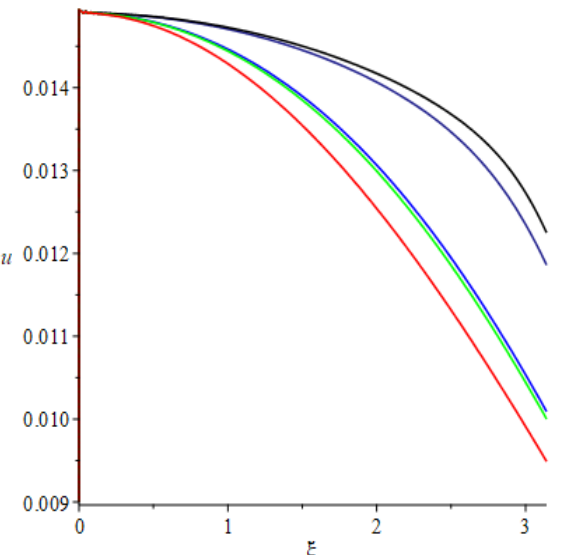
Figure 9. Graphs of the dependence of the phase velocity u on the wave number | ξ | in dimensionless variables. Red color: monodisperse phonon crystal 0.5 + 0.5. Black color: Medium drop + Medium bubble + Medium drop + small bubble with dimensions 0.25 + 0.3 + 0.25 + 0.2, a graph of phase velocities. Green color: 0.05 + 0.25 + 0.45 + 0.25. The structure of the fundamental cell is drop + bubble + drop + bubble. Blue color: 0.4 + 0.4 + 0.1 + 0.1. The structure of the fundamental cell is drop + bubble + drop + bubble. Dark blue (navy ) 0.3 + 0.3 + 0.2 + 0.2. The structure of the fundamental cell is drop + bubble + drop + bubble.